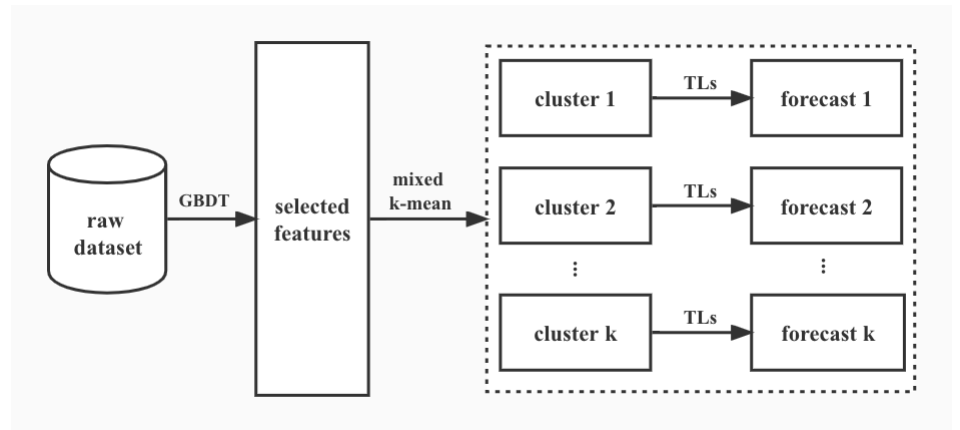
Figure 1. Fluxogram of